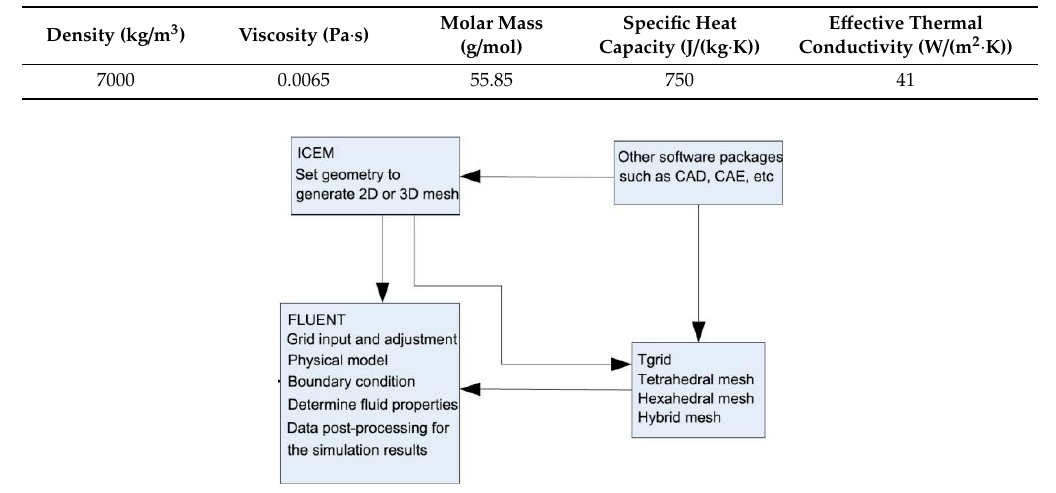
Table 3. Thermal physical properties of molten steel.